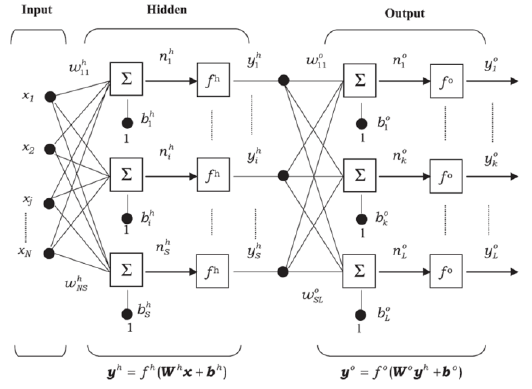
Figure 3: Basic diagram of an MLP neural network (Agirre- Basurko et al.,